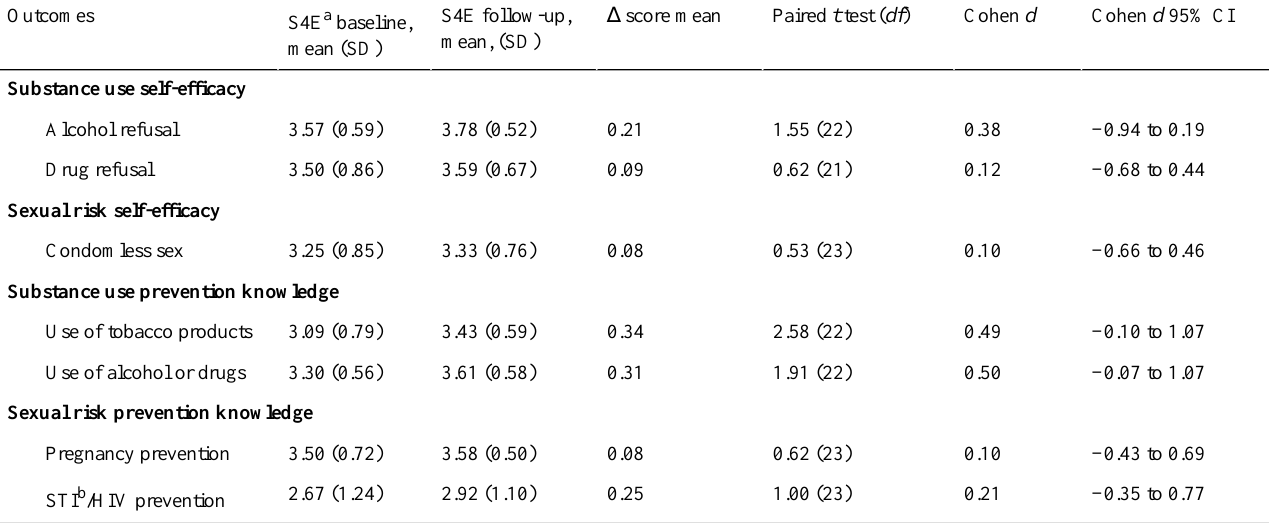
Table 3. Storytelling 4 Empowerment intervention effects on self-efficacy and prevention knowledge (n=25).